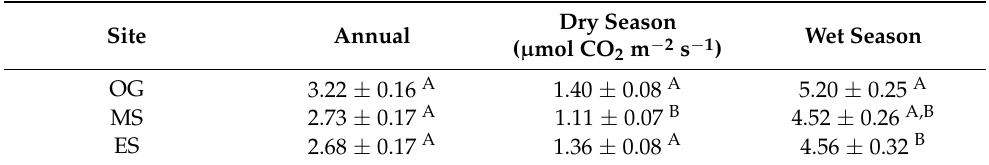
Table 3. Mean annual and seasonal rates of soil respiration (R S ) along a forest succession from tropical dry forest in northwestern Mexico. Data are presented as mean ± standard error. Capital letters denote significant differences among sites ( p < 0.05).